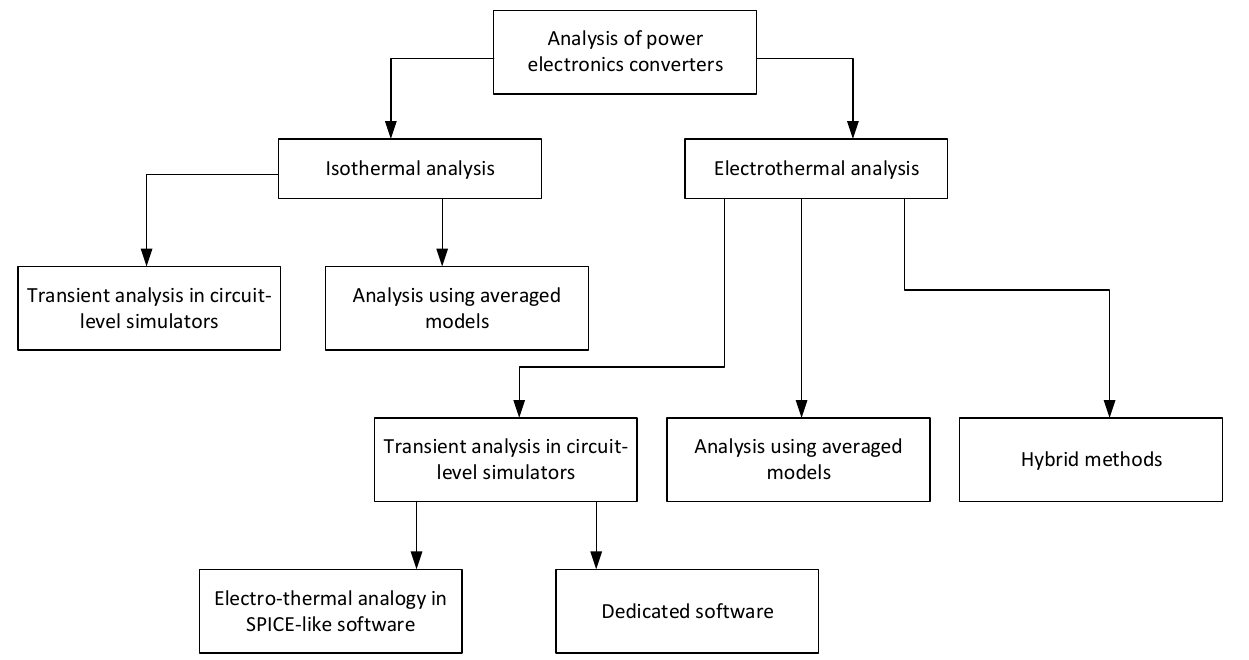
Figure 1. Classification of simulation methods for power electronic